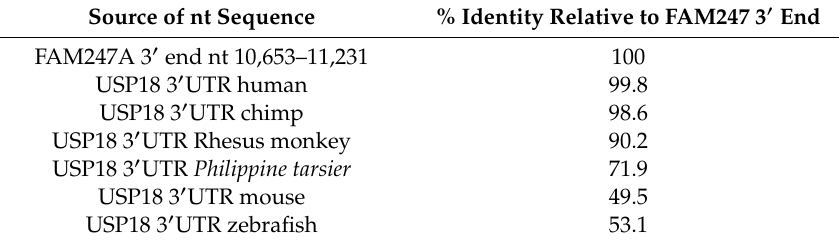
Table 3. Nucleotide sequence identities of 3 (cid:48) UTR of USP18 from di ff erent species. Source of nt Sequence Figure 5. Alignment of the USP18 terminal exon amino acid sequences from seven species compared with the FAM247 translated amino acid sequence. Data were obtained using the EBI Clustal Omega sequence alignment and phylogeny programs. The EMBL-EBI Clustal Omega Multiple Sequence Alignment program [19] at website http://www.ebi.ac.uk/Tools/msa/clustalo/ was used for aa sequence alignment. ( Top ) Phylogenetic tree of USP18 terminal exon aa sequences from seven species and the FAM247 aa sequence. ( Middle ) The percent identities were created using Clustal 2.1. ( Bottom ) Alignment of aa sequences.